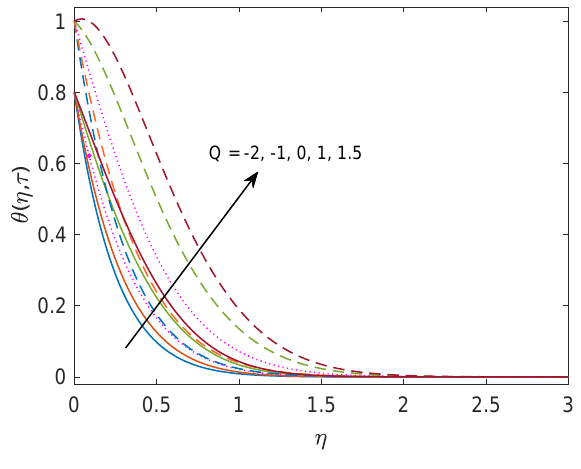
Figure 14. Effect of different values of Q.